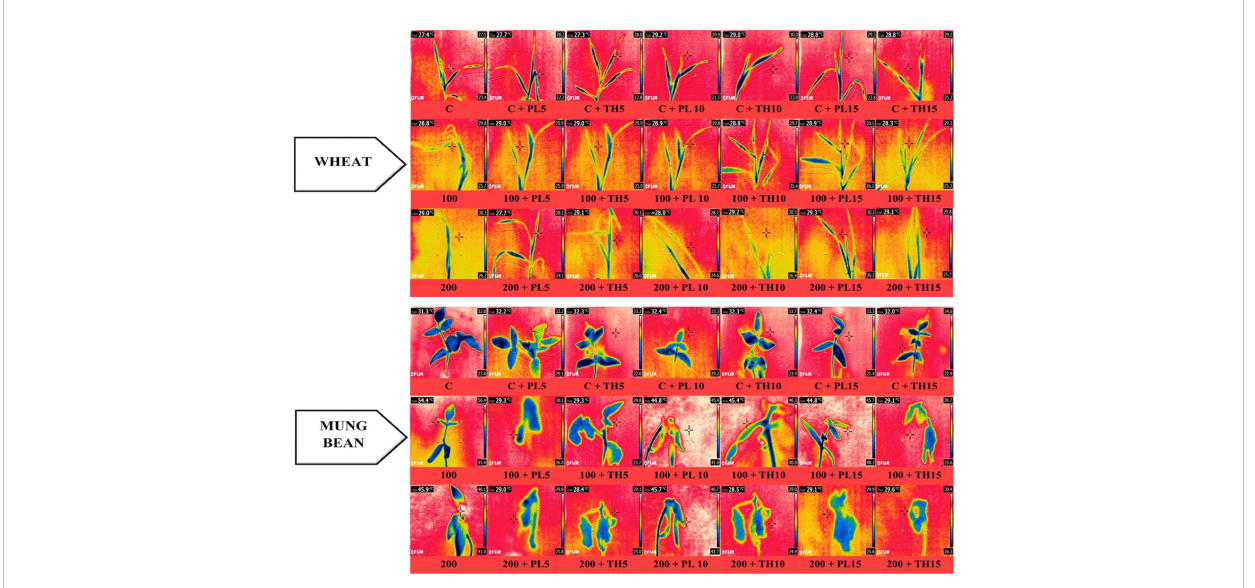
FIGURE 8 Effects of seed priming with fungal endophytes on infra-red thermal images of wheat and mung bean grown under saline environment. The symbols on the horizontal axis represents: C = Seed without priming, PL5= Seed priming with Paecilomyces lilacinus for 5 mins, PL 10= Seed priming with Paecilomyces lilacinus for 10 mins, PL 15= Seed priming with Paecilomyces lilacinus for 15 mins, TH 5= Seed priming with Trichoderma hamatum for 5 mins, TH 10= Seed priming with Trichoderma hamatum for 10 mins, TH 15= Seed priming with Trichoderma hamatum for 15 mins. 0 (C), 100 and 200 mM represents different salinity (NaCl) levels.